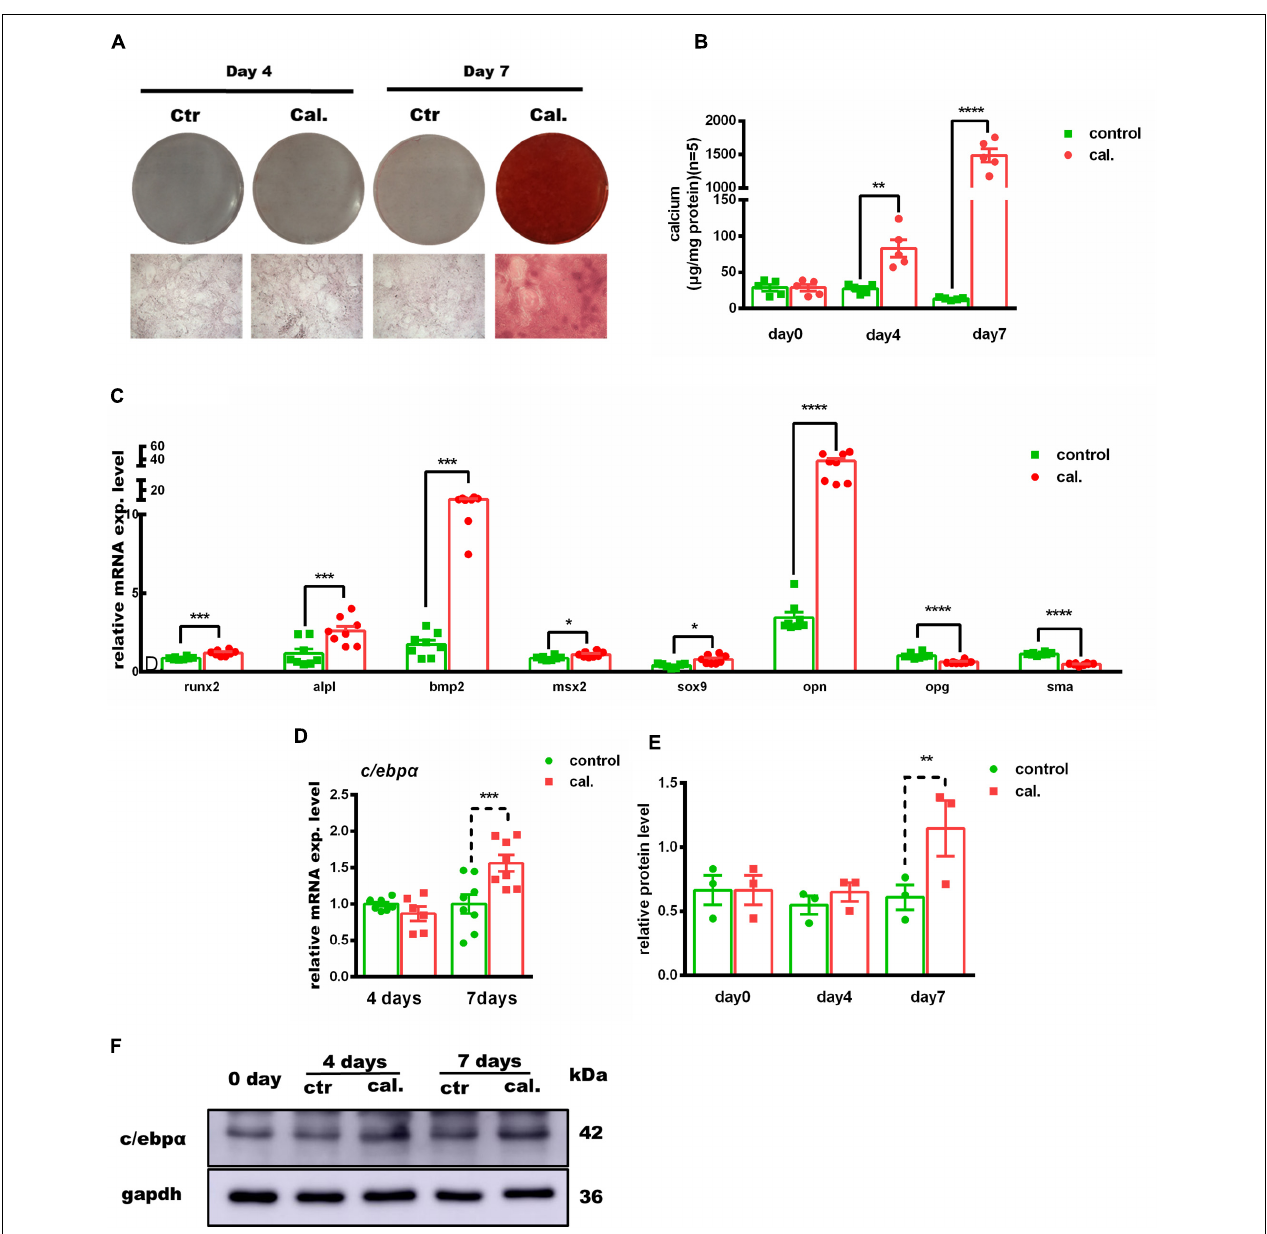
FIGURE 2 | Association of c/ebp α with vascular calcification in the primary vascular smooth muscle cell (VSMC) vascular calcification model. (A) Representative images of alizarin red staining confirmed calcium deposition in VSMCs treated with calcium/phosphate or control medium. Typical areas at 10 × magnifications are placed beside the respective panels. (B) Quantitative calcium assay for VSMCs treated with calcium/phosphate or control medium in different days ( n = 5). (C,D) Real-time PCR analysis for the mRNA expression of Runx2 , Alpl , Bmp2 , Msx2 , Sox9 , Opn , Opg , Sma , and C/ebp α in VSMCs vascular calcification for indicated experimental groups. The target mRNAs were normalized to β -actin mRNA and are graphed ( n = 8). (E) Semiquantitative analysis of Western blotting for C/EBP α protein expression using ImageJ software ( n = 3). (F) Representative images of Western blotting of VSMCs vascular calcification for C/EBP α protein expression. * p < 0.05, ** p < 0.01, *** p < 0.001, **** p <